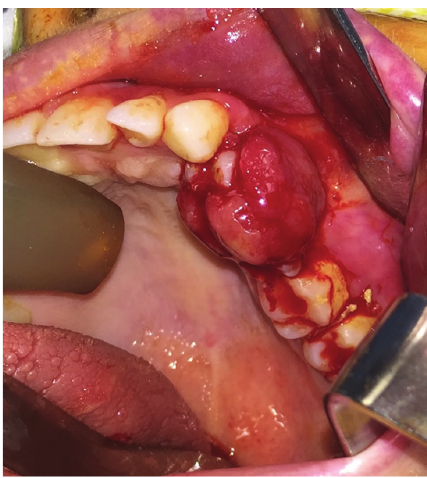
Figure 5: Recurrent lesion two months after initial excision. Teeth numbers 24 and 25 (international nomenclature) are mobile and enveloped by the mass. Tooth number 26 (international nomencla- ture) is mobile and has a > 10mm probing depth.